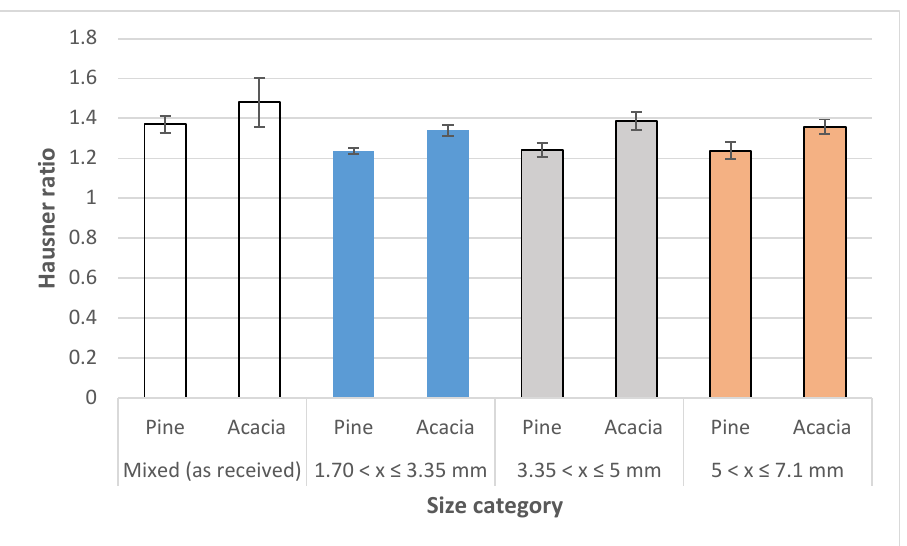
Figure 7. Hausner ratios for pine and acacia.